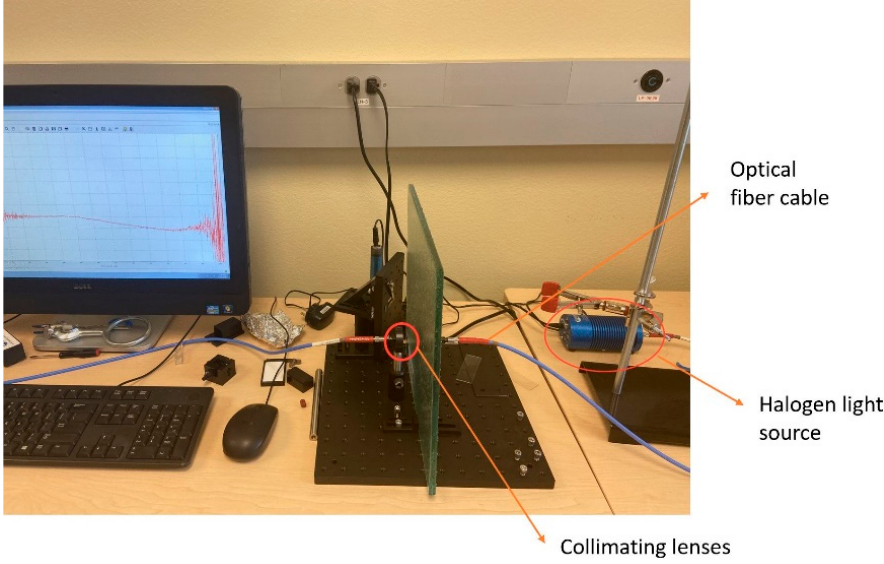
Figure 4. Instrument setup for transmittance test (Science research laboratory, UTSA).